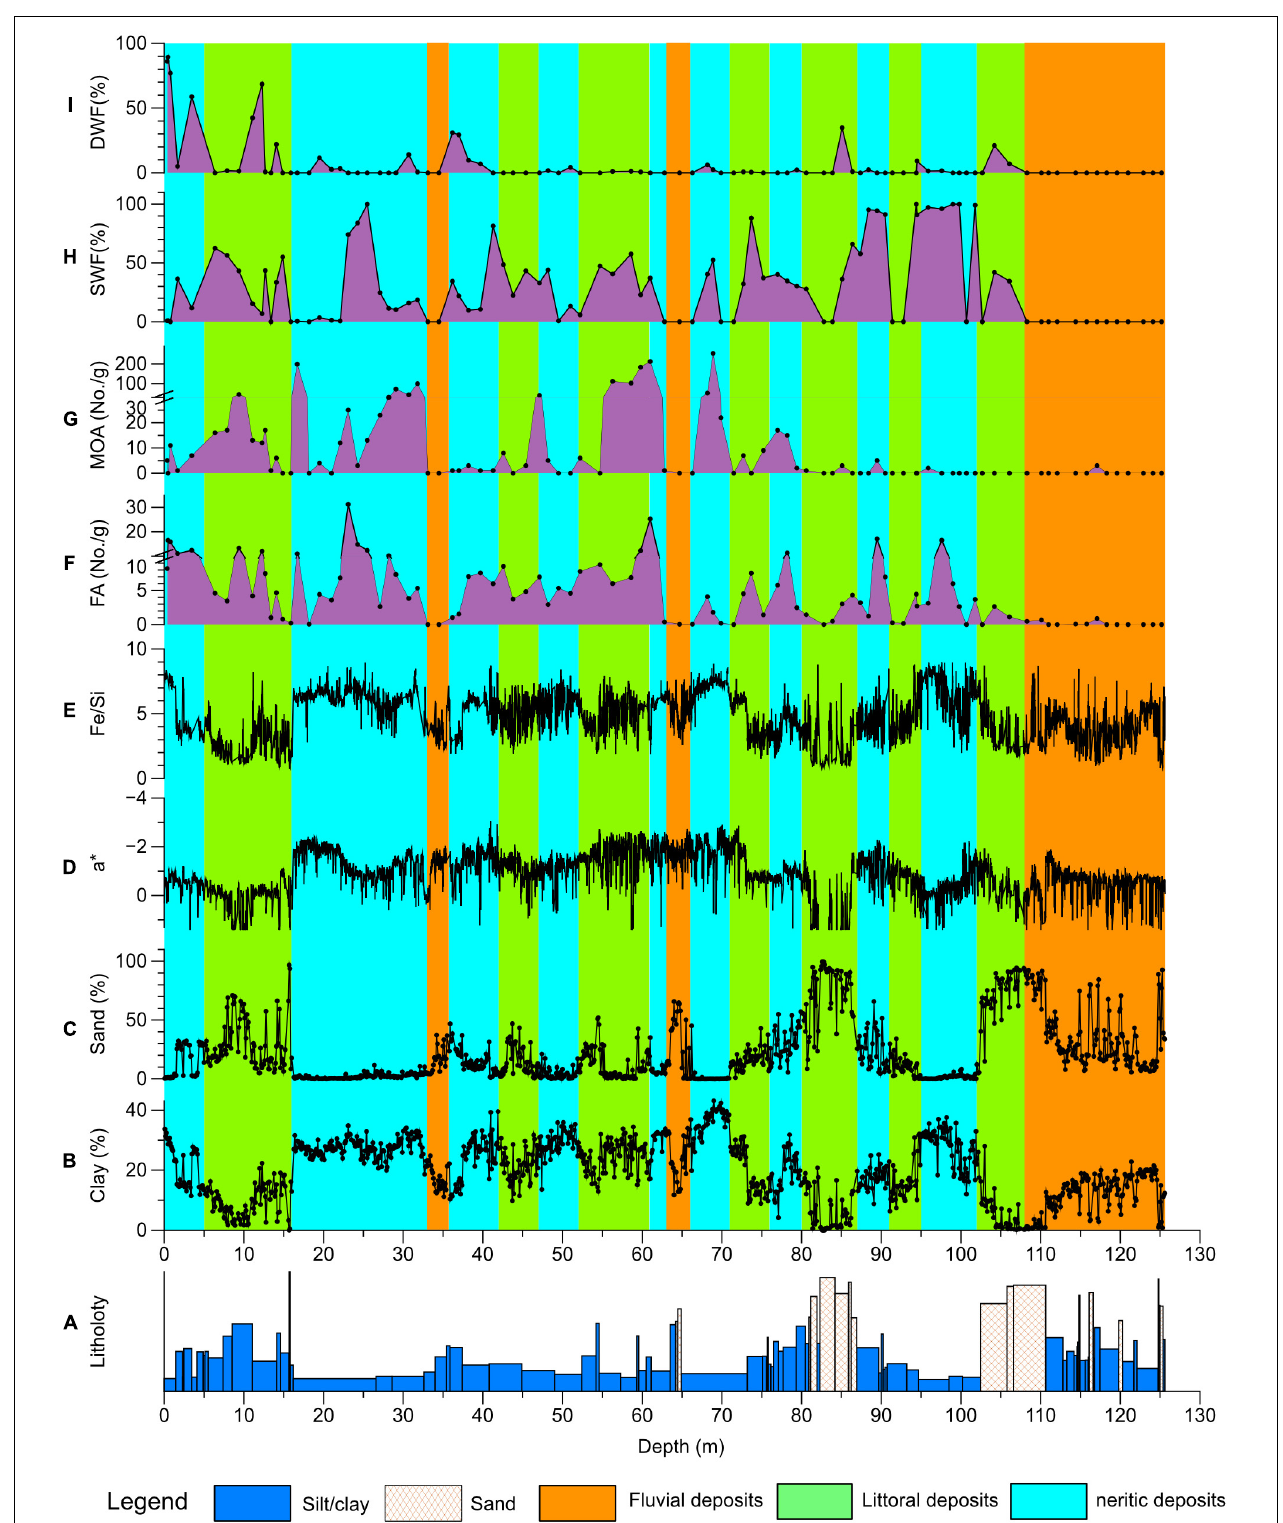
FIGURE 2 | Sedimentary environment and proxies of core NHH01. Lithology ( A ; Liu et al., 2014), clay (B) and sand content ( C ; Liu et al., 2014), sediment redness ( D ; a*), XRF-scanning Fe/Si ratio (E) , foraminifera abundance ( F ; FA, Liu et al., 2014), marine ostracods abundance (G) , and fractions of shallow (H) and deep (I) water